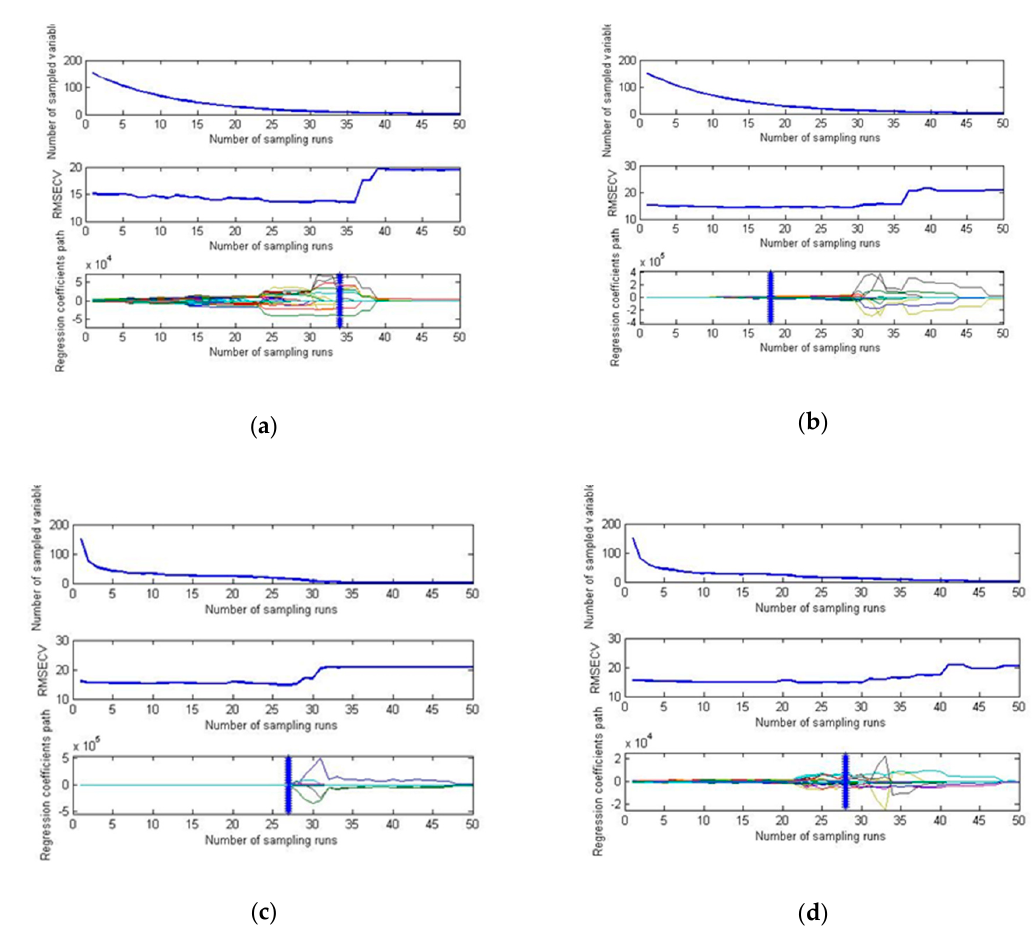
Figure 5. Hyperspectral characteristic wavelength selection process based on the CARS algorithm pretreated by ( a ) MSC; ( b ) S-G-MSC; ( c ) S-G-SNV; and ( d ) SNV.